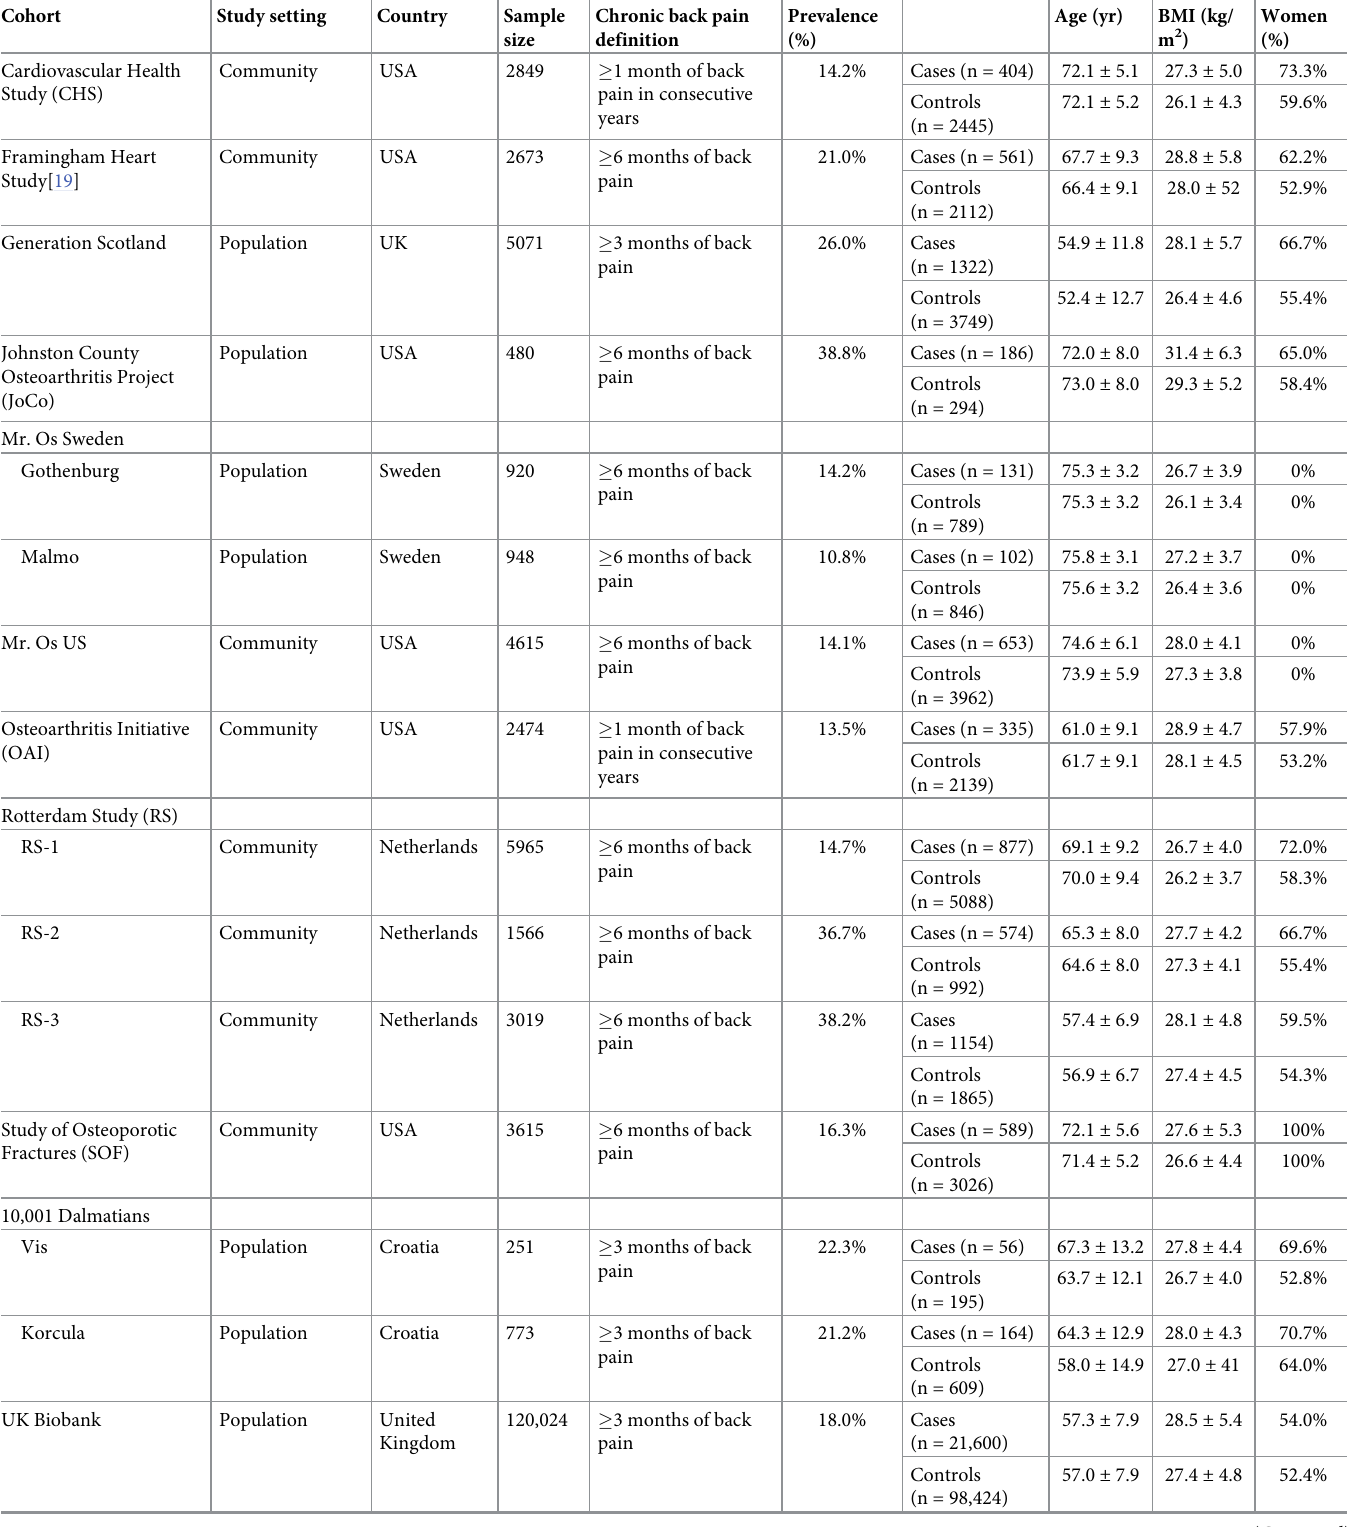
Table 1. Cohorts in meta-analysis of genome-wide association studies of chronic back pain (European